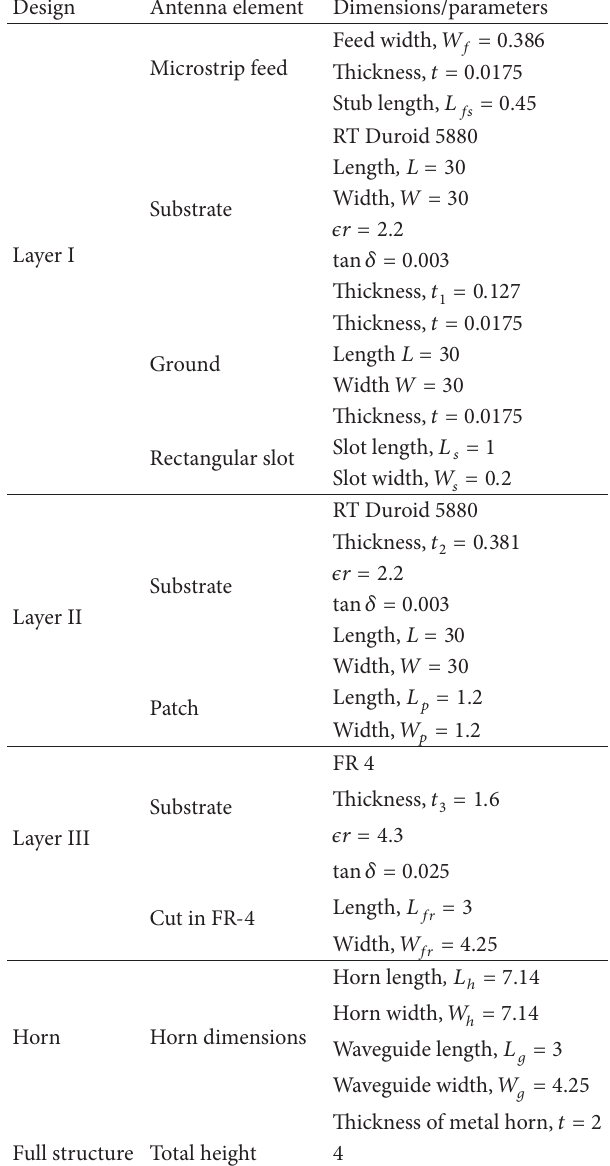
Table 1: Parameters of proposed antenna in mm.